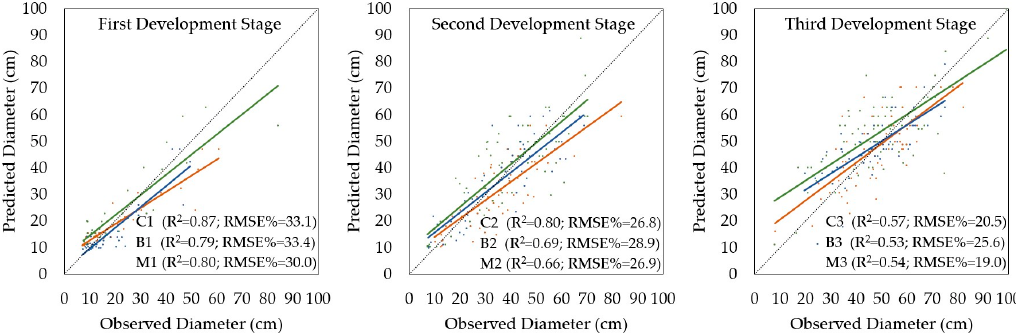
Figure 5. Regression between diameter of field-measured trees (observed) and remotely-sensed trees (predicted) for coniferous strata (brown), broadleaved strata (green), and mixed strata